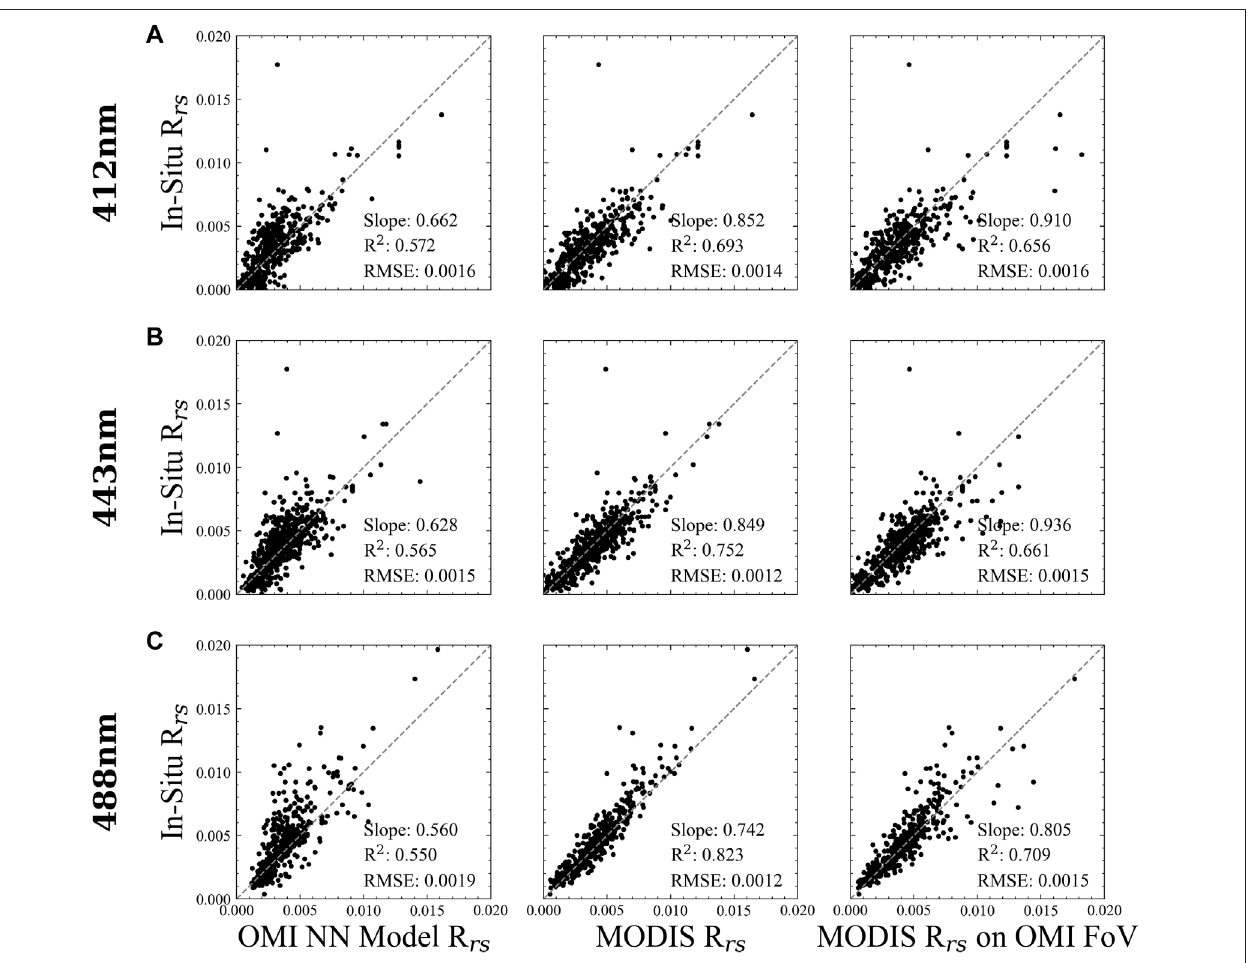
FIGURE 15 | Similar to Figure 14 but for R rs . (A) are for 412 nm, (B) are 443 nm, and (C) are 488 nm. There are 340 co-located points in the comparison.